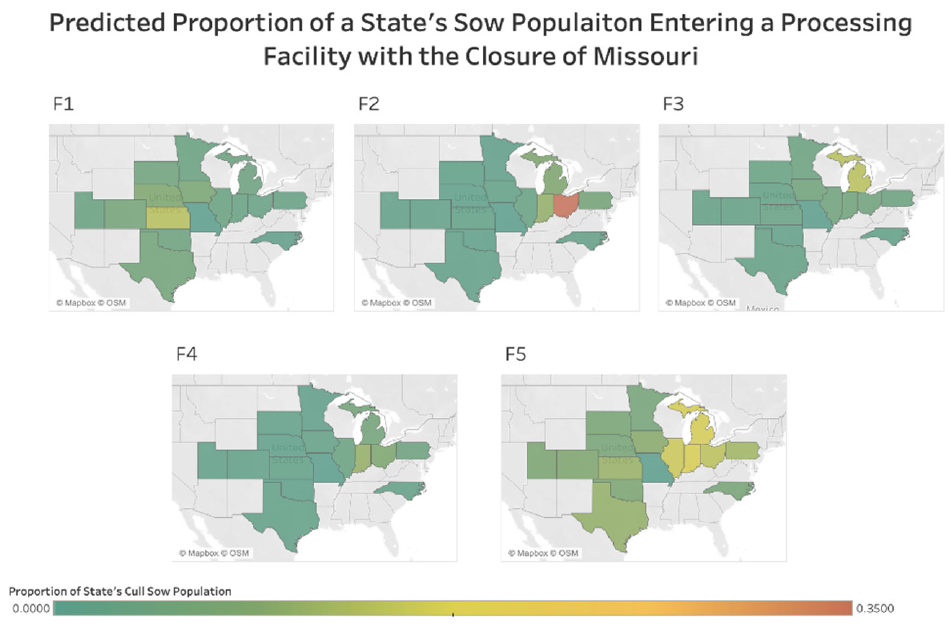
Figure 3. The predicted proportion of a state’s cull sow population that enters each terminal processing facility F1–F5, with a closure of movements to and from Missouri. Each pane labeled F1, F2, F3, F4, F5 represents a different processing facility.